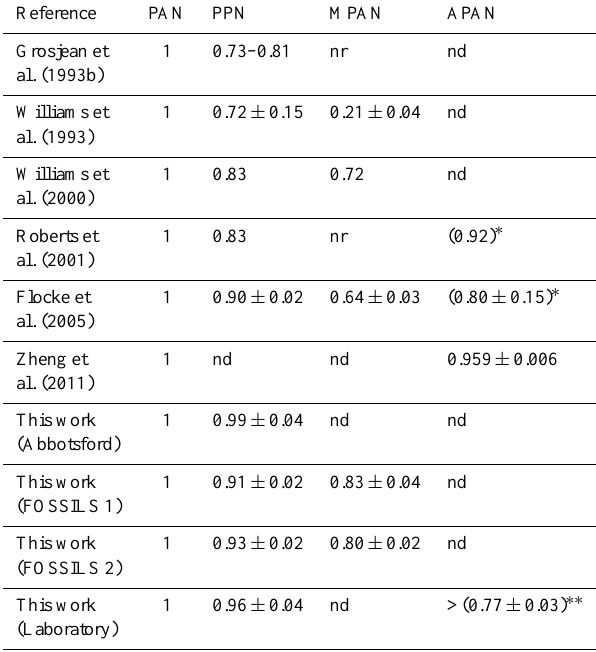
slope = 0 . 84 ± 0 . 01, Fig. 11a), and improves after the correc- and NO 2 is applied ( r = 0 . 93, slope = 0 . 96 ± 0 . 01, Fig. 11c). For PPN, the uncorrected TD-CIMS data do not corre- Fig. 11b), but more so after the correction for inlet